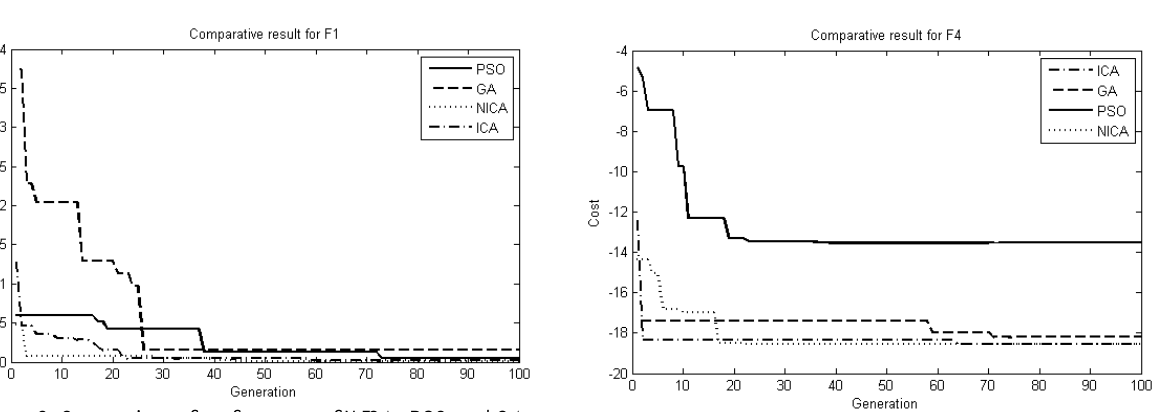
Figure 3. Comparison of performance of NICA, PSO and GA for minimization of F 1 The good convergence rate of NICA could be deduced from Figure 4; NICA wants to find the global optimum faster than others and hence has a higher convergence rate.